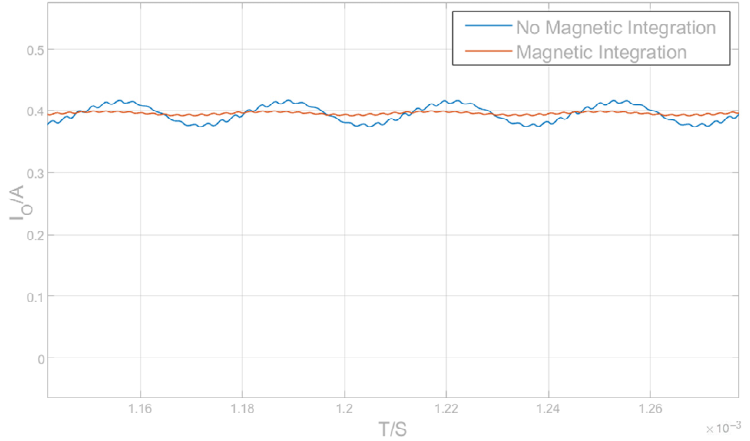
Figure 12. Comparison of output current before and after adopting integrated magnetic technology.